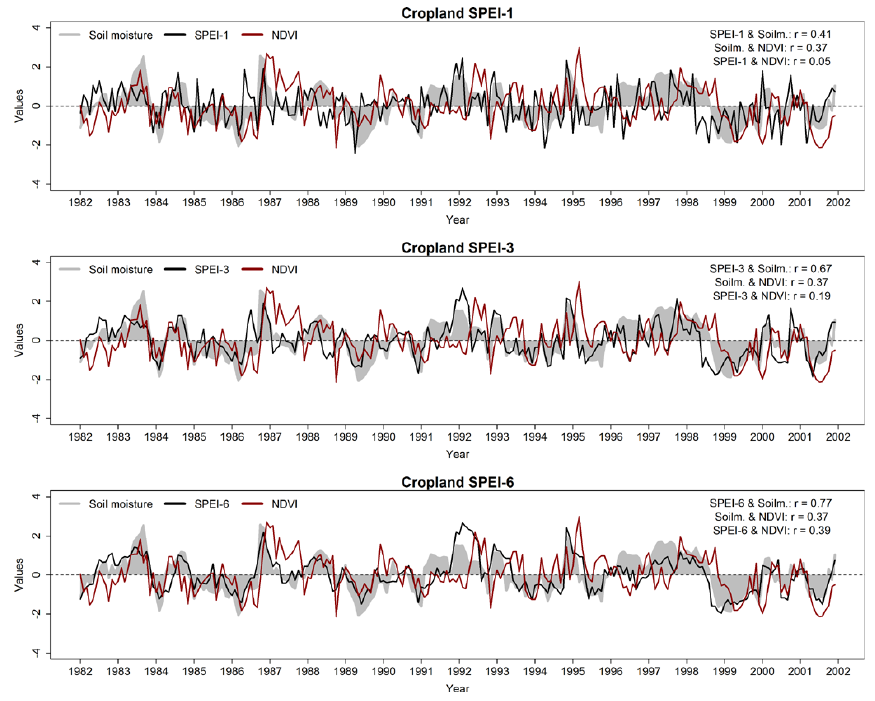
Fig. 3. Time series of simulated soil moisture, NDVI and multiple timescales of the SPEI; r refers to the correlation coefficient.